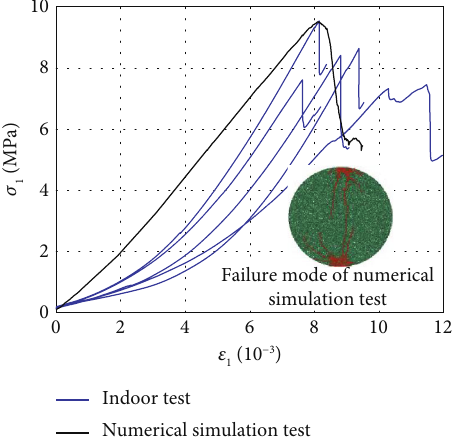
− ε laboratory test, curve of σ 1 1